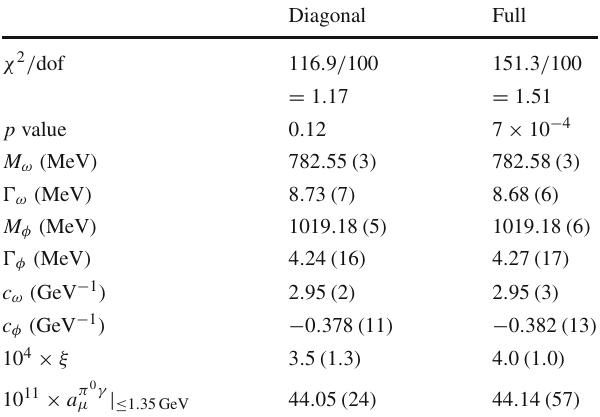
Table 2 Fits to the combined SND data sets [84–87], for diagonal uncertainties and full covariance matrices. All errors refer to fit uncer- tainties only